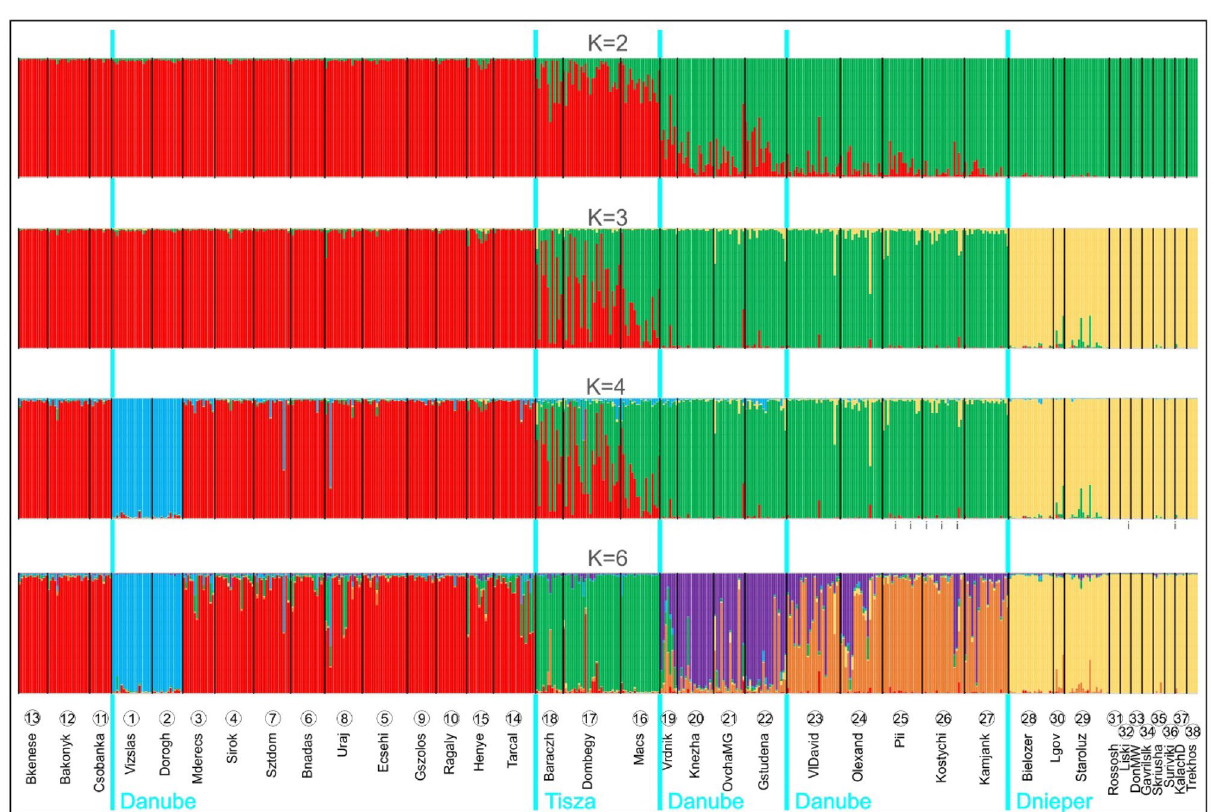
Figure 8. Hierarchical Bayesian clustering of individuals into K = 2, 3 and 4 and 6 groups by the software STRU CTU RE. Main rivers separating the population groups are indicated on the map by a light blue line and the name of the river. Populations, arranged along a longitudinal gradient, are indicated below the bar plots at the corresponding place by their number as given in Table 1 and their